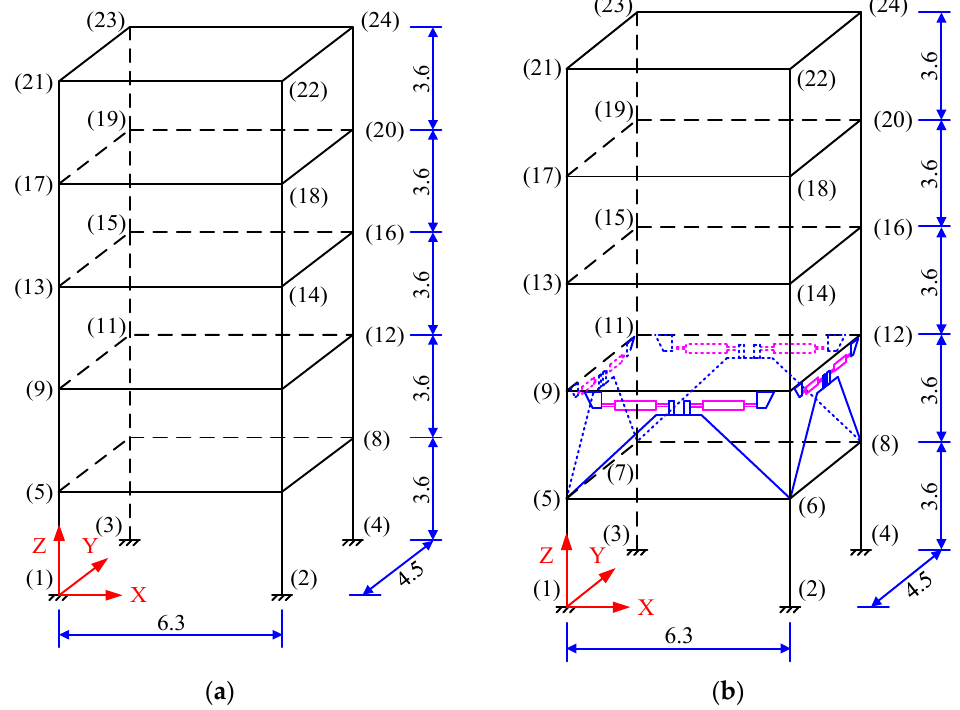
Figure 6. Three-dimensional diagram of the RC frame structure with and without an MRD (unit: m). ( a ) Without MRDs; ( b ) with MRDs.